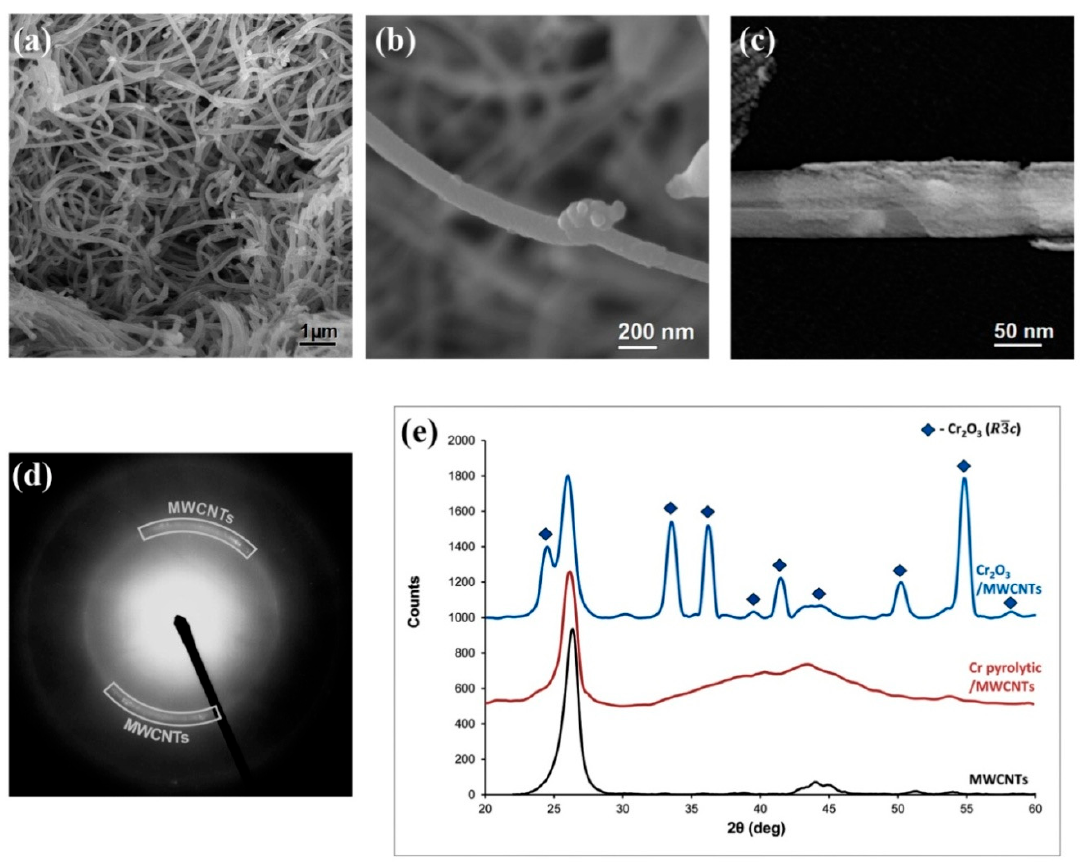
Figure 4. The Cr / MWCNTs nanocomposite research results: ( a , b ) SEM and ( c ) TEM micrographs of the Cr / MWCNTs nanocomposite; ( d ) selected area electron di ff raction (SAED) image of the Cr / MWCNTs nanocomposite; ( e ) X-ray di ff raction (XRD) patterns of the initial MWCNTs (black), the Cr / MWCNTs hybrid material (red), and the Cr / MWCNTs hybrid material after annealing at 400 ◦ C in air (blue).